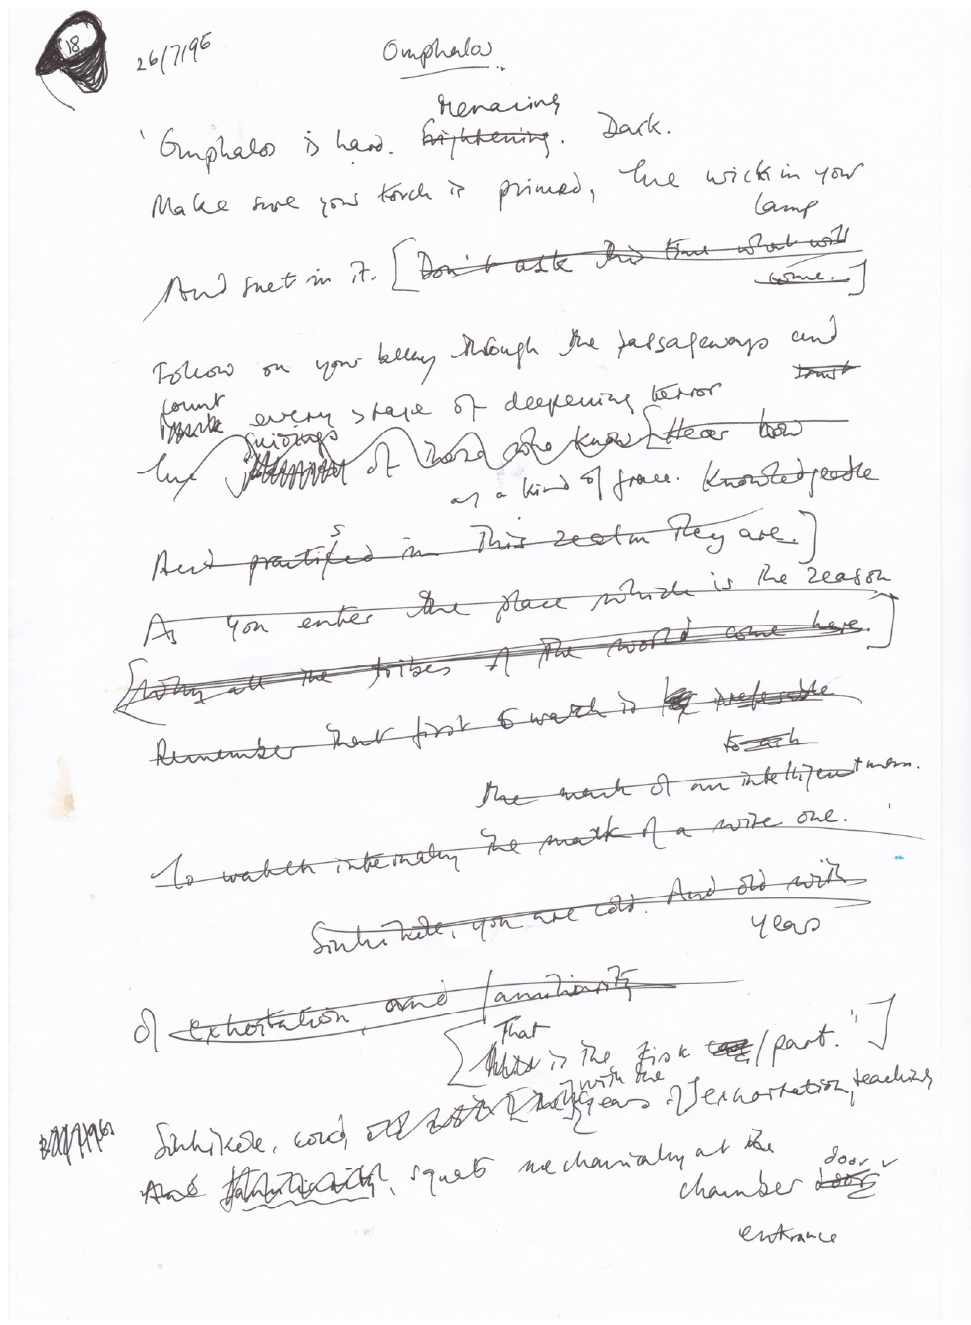
Figure A1. Omphalos